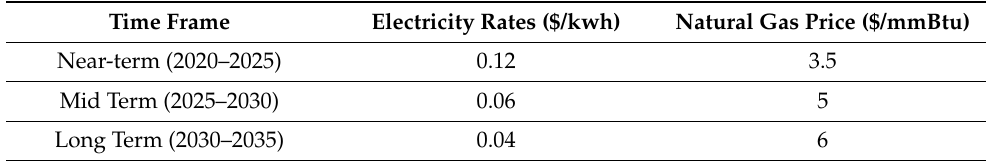
Table A2. Feed stock prices